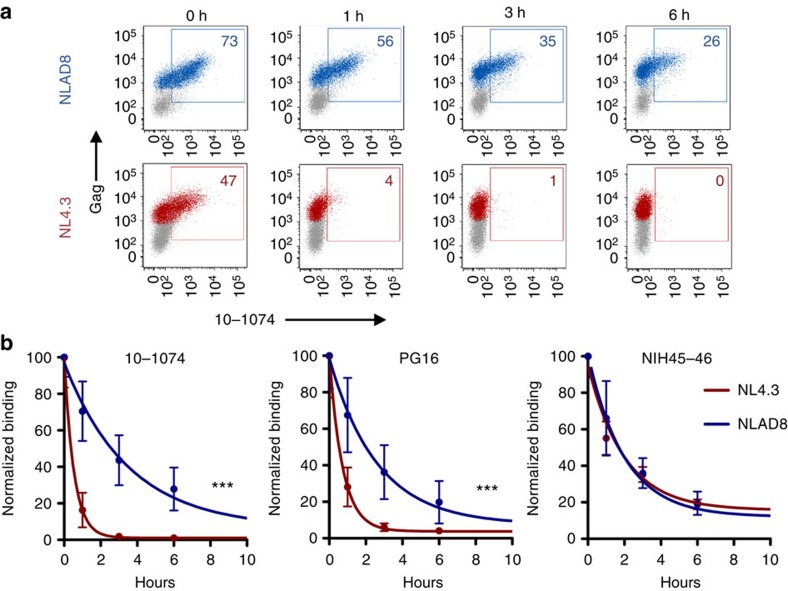
Binding and stability of bNAbs at the surface of HIV-1-infected lymphocytes.(a) CEM-NKR cells infected with HIV-1 (NLAD8 or NL4.3) were incubated with 10–1074 bNAb (at 4 °C) and surface levels were analysed by flow cytometry after the indicated incubation times at 37 °C. The numbers indicate the % of bNAb+ cells among infected (Gag+) cells. One representative experiment (out of six) is shown. (b) Decrease of surface stainings of the indicated bNAbs after incubation at 37 °C. (N=3–6 experiments; error bars indicate s.e.m. and significance was determined by comparing NLAD8- and NL4.3-infected cells ***P<0.001 extra sum-of-squares F test).